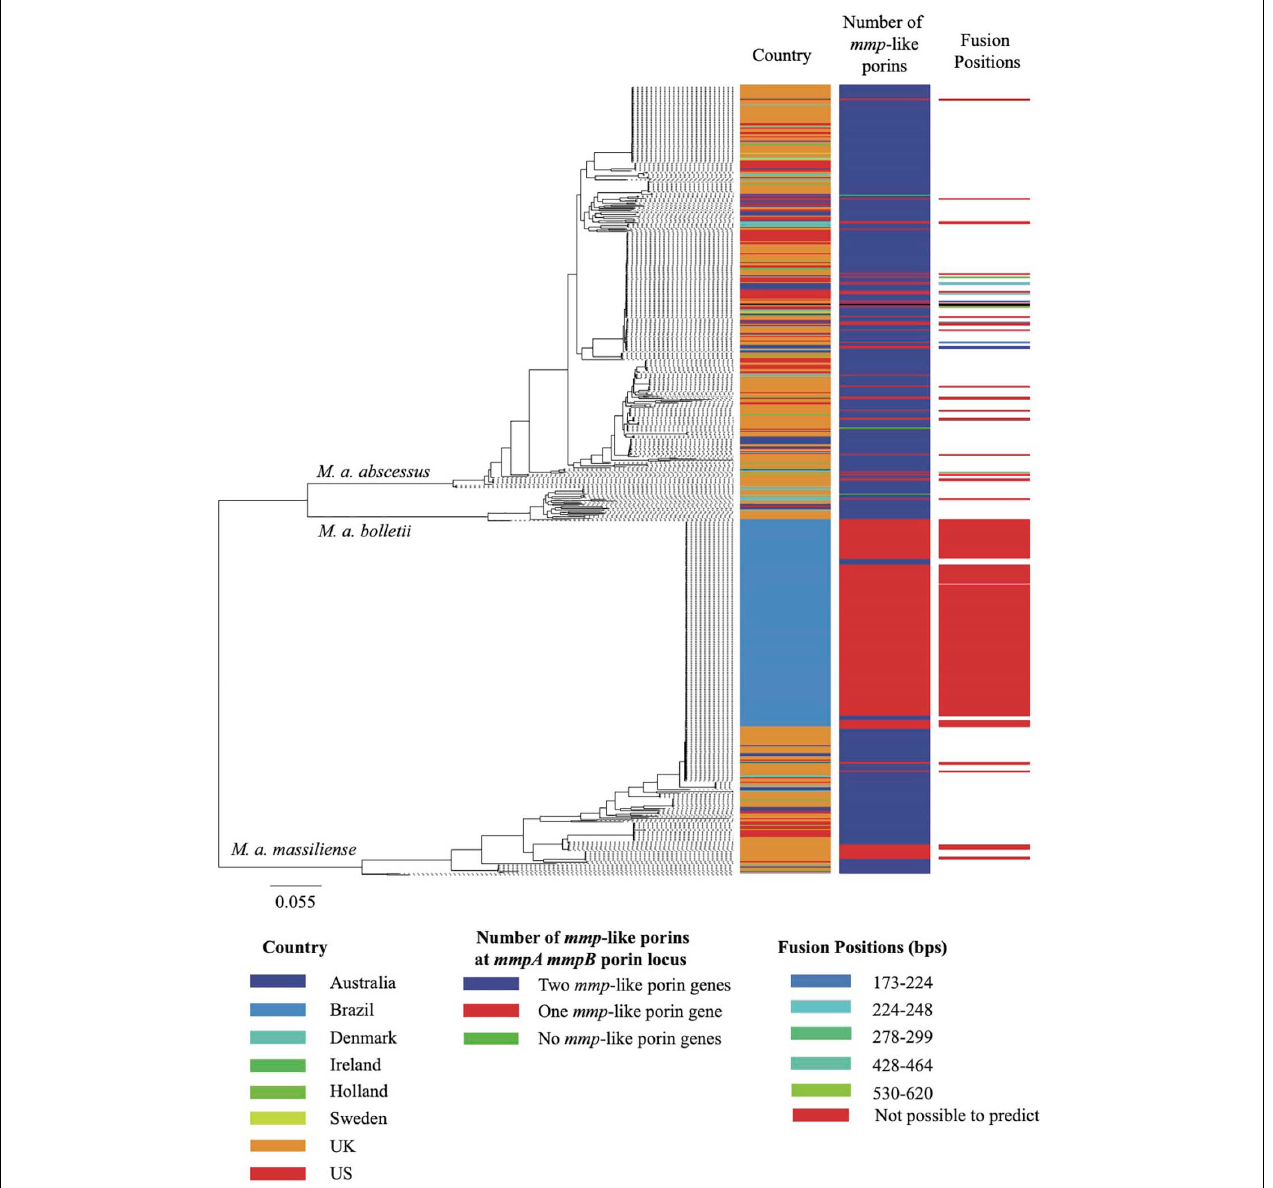
FIGURE 2 | Maximum likelihood phylogeny of the MABSC global population. The global population shown here consist of 526 isolates associated with pulmonary infections and 188 isolates associated with the epidemic of post-surgical wound infections in Brazil. The metadata aligned shows, for each isolate, the country of isolation, the predicted composition of the porin locus and the isolates for which the fusion position was predicted. The scale bar on the phylogeny represents the number of substitutions per variable site.